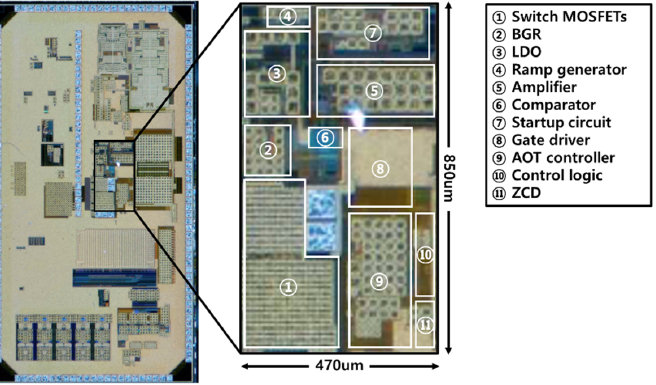
Figure 11. Microphotograph of proposed dual-mode DC-DC buck converter prototype.